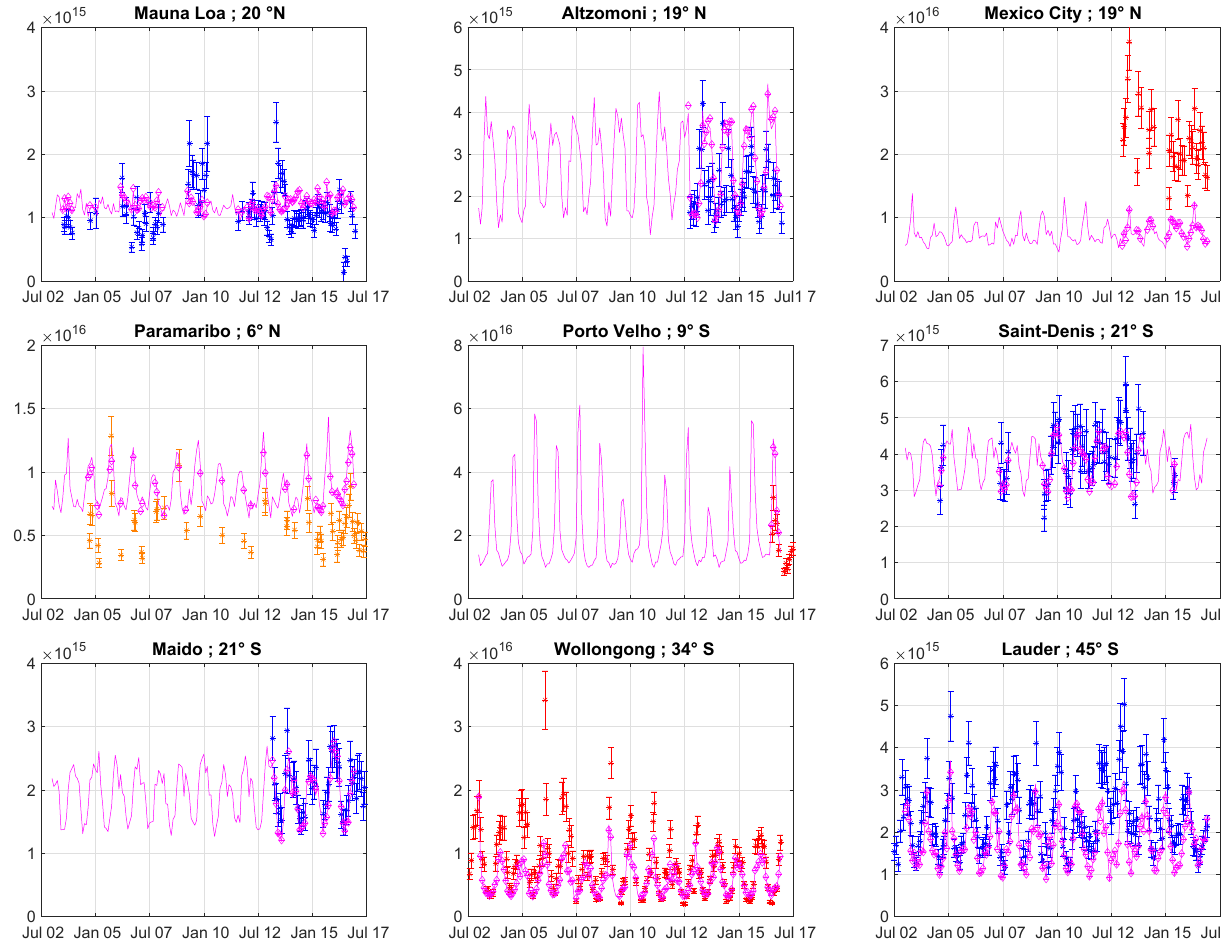
Figure 7. Monthly means of HCHO total columns (moleccm − 2 ) at each station for FTIR measurements are shown with stars (clean, intermediate, and high-level HCHO sites are shown using blue, orange, and red colours) and model data (magenta line for raw model data; magenta diamonds for model data smoothed by the FTIR AK). The FTIR error bars represent the total uncertainties in monthly means which, due to monthly averaging, are mainly the systematic uncertainties. The model error bars represent the standard deviation of the model for each